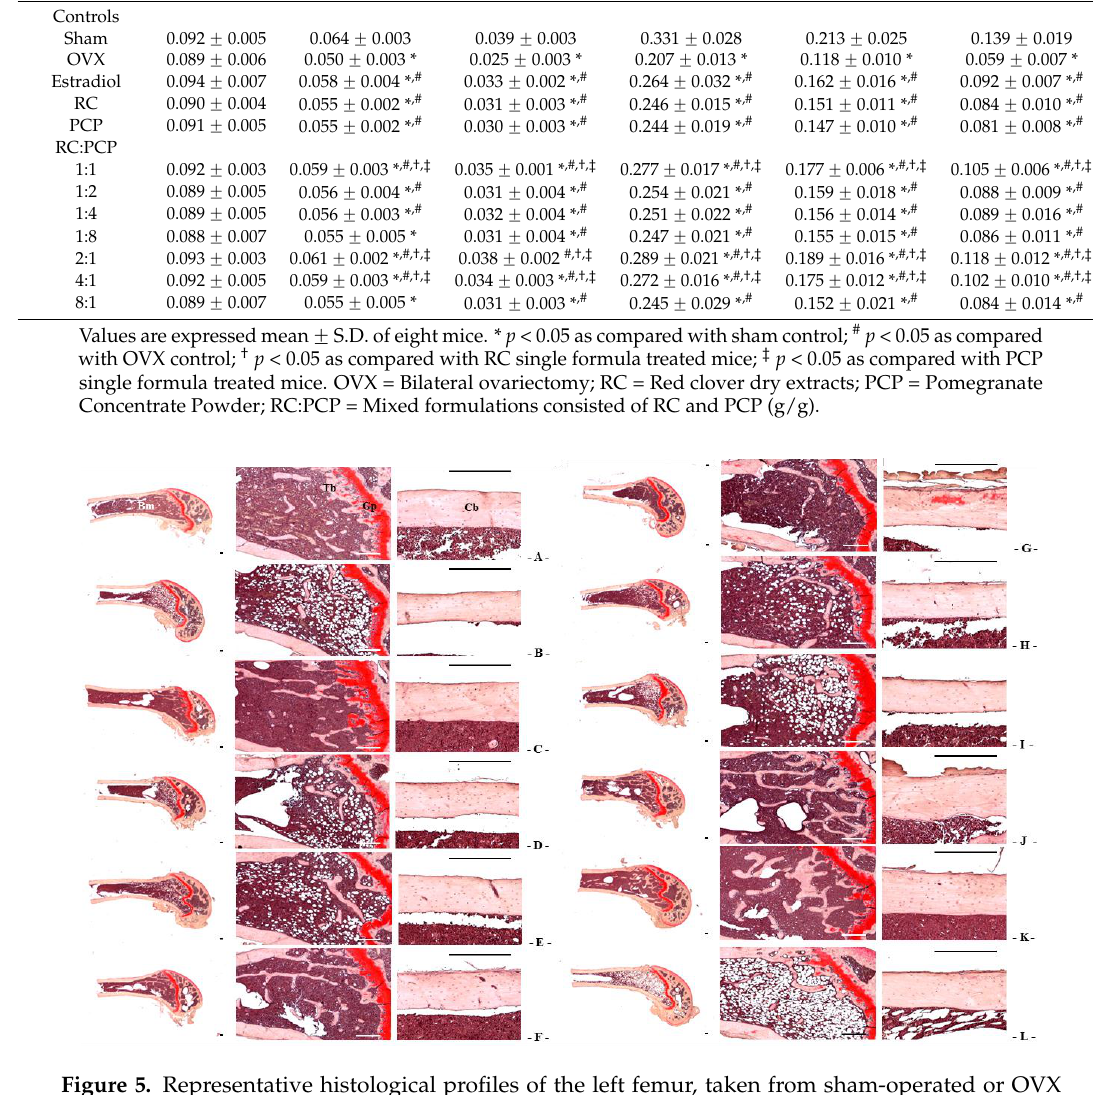
Figure 5. Representative histological profiles of the left femur, taken from sham-operated or OVX ddY